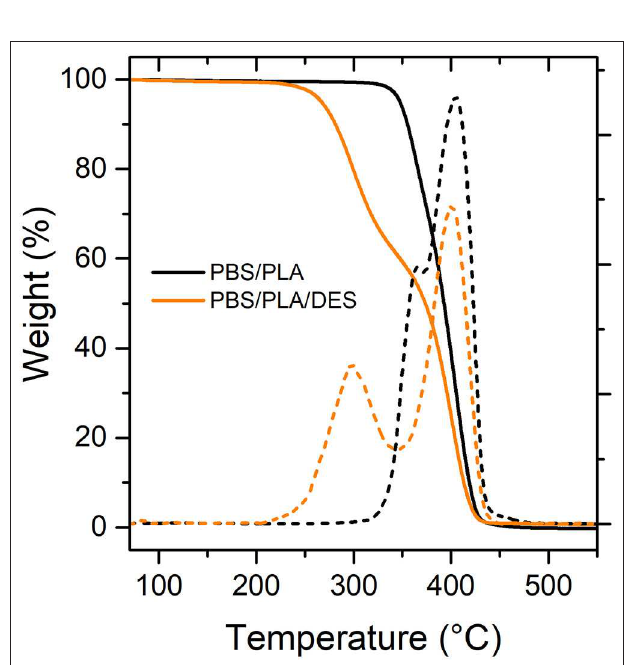
FIGURE 4 | Thermogravimetric analyses (TGA) traces of poly(butylene succinate) (PBS)/poly(lactic acid) (PLA) blends (60:40) wt phr. Dashed curves are derivative curves.